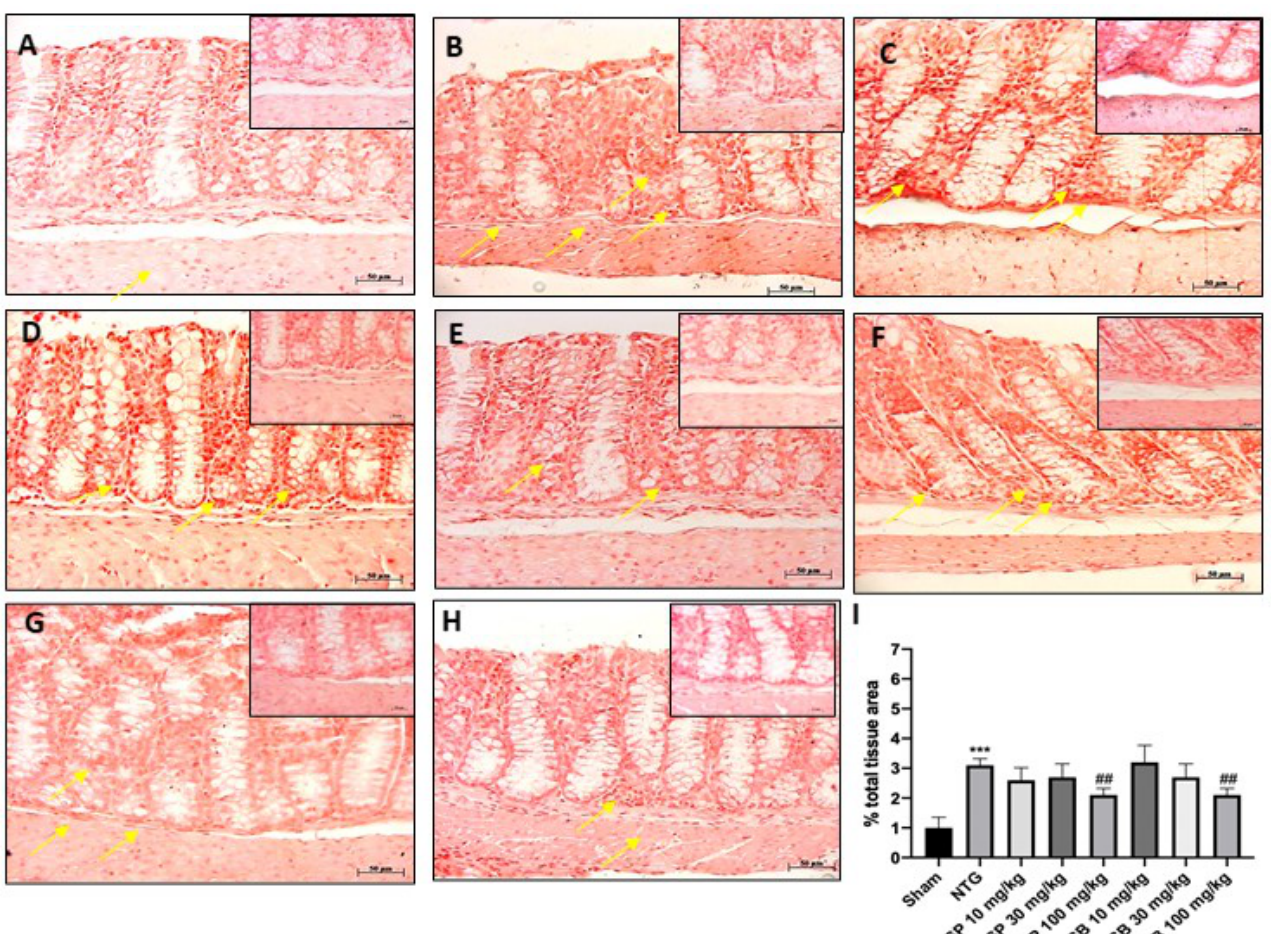
Figure 4. SCFAs treatment reduced P-selectin expression. Immunohistochemical localization re- vealed that NTG group ( B ) was characterized by high expression of P-selectin compared to sham group ( A ) however, SCFA treatment ( D , E , G , H ) significantly decreased P-selectin expression. No significant difference was revealed in mice treated with 10 mg/kg of SCFAs ( C , F ). The yellow arrows indicated positive cells. ( I ) *** p < 0.001 vs. sham; ## p < 0.01 vs. NTG.